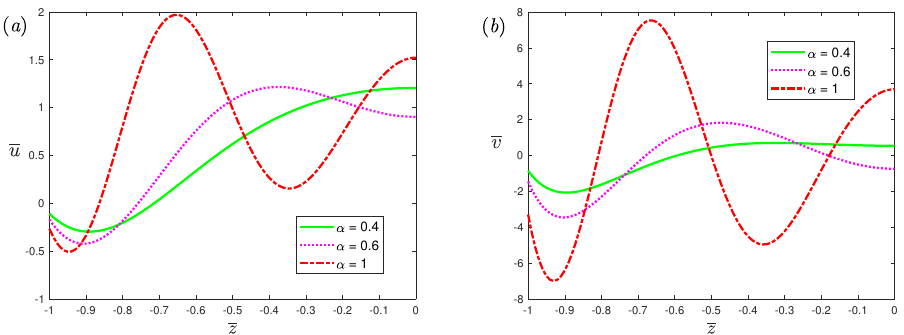
Figure 3. The dimensionless velocity profiles, ( a ) spanwise; ( b ) streamwise, of fractional Maxwell model across half channel width for different dimensionless parameters α at t = π /6, β = 1, De = 5, L = 0.03, K = 10, ω = 5, Ha = 0.5.